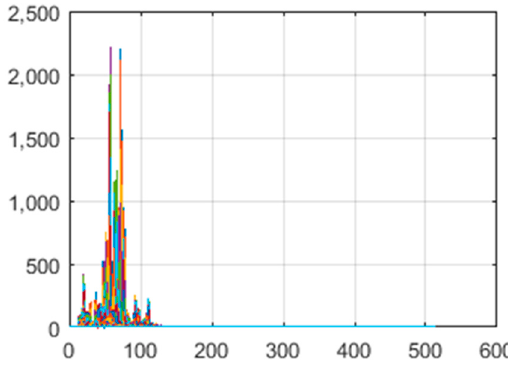
Figure 3. Power spectral function graphs.